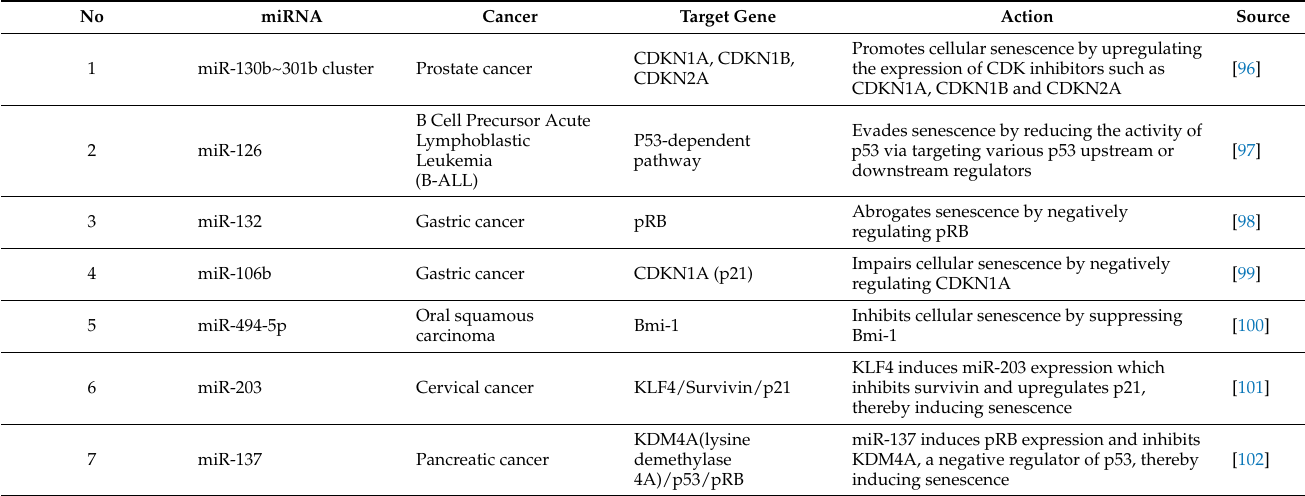
Table 5. The miRNAs implicated in